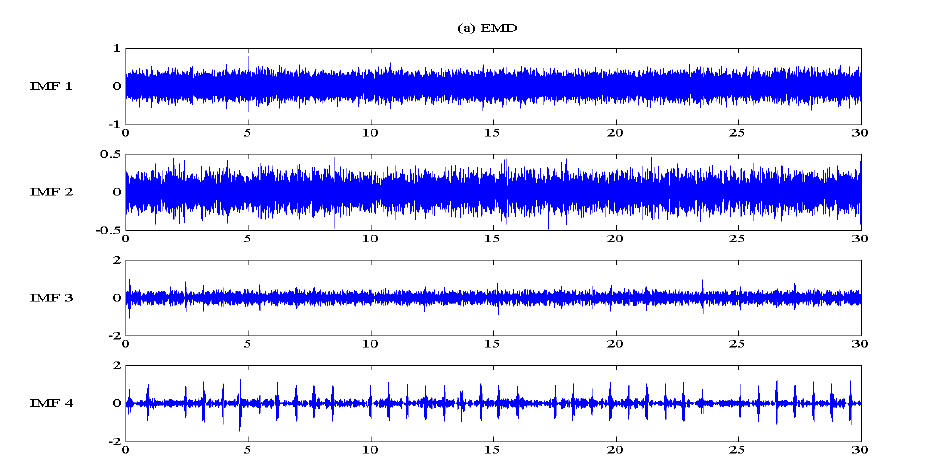
Figure 4. Illustration of IMF distribution of a ventricular arrhythmia ECG (V1) with 100% composite noise by: (a) EMD, and (b) EEMD. From top to bottom is low level IMF to high level IMF. Signal durations are 30